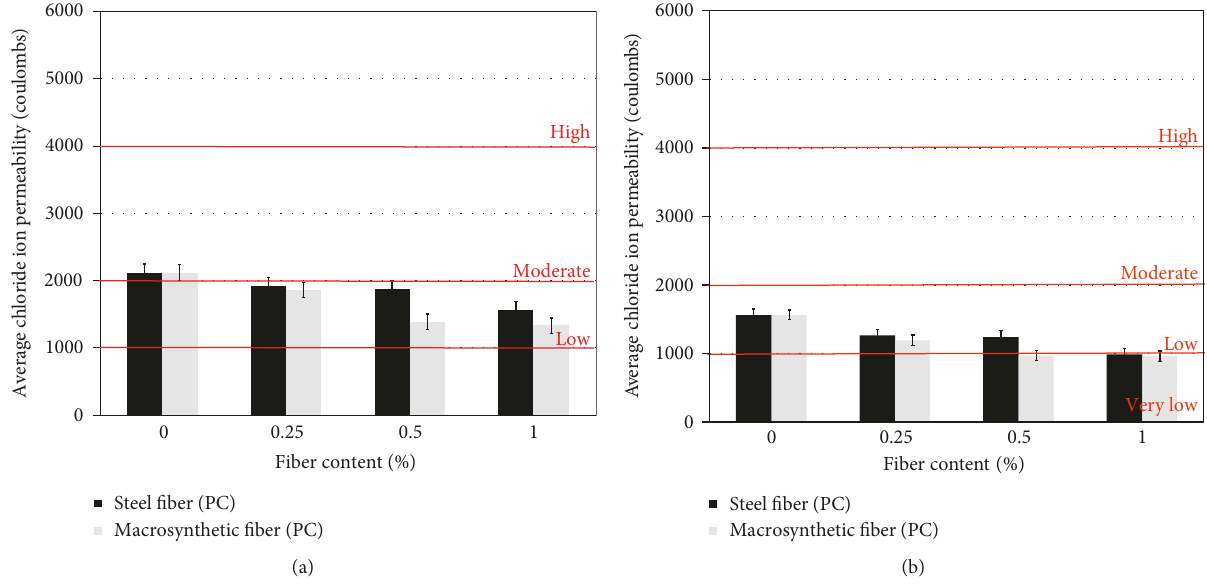
Figure 15: Chloride ion penetrations of BSC segments with reinforcing types. (a) 40MPa. (b) 60 MPa.